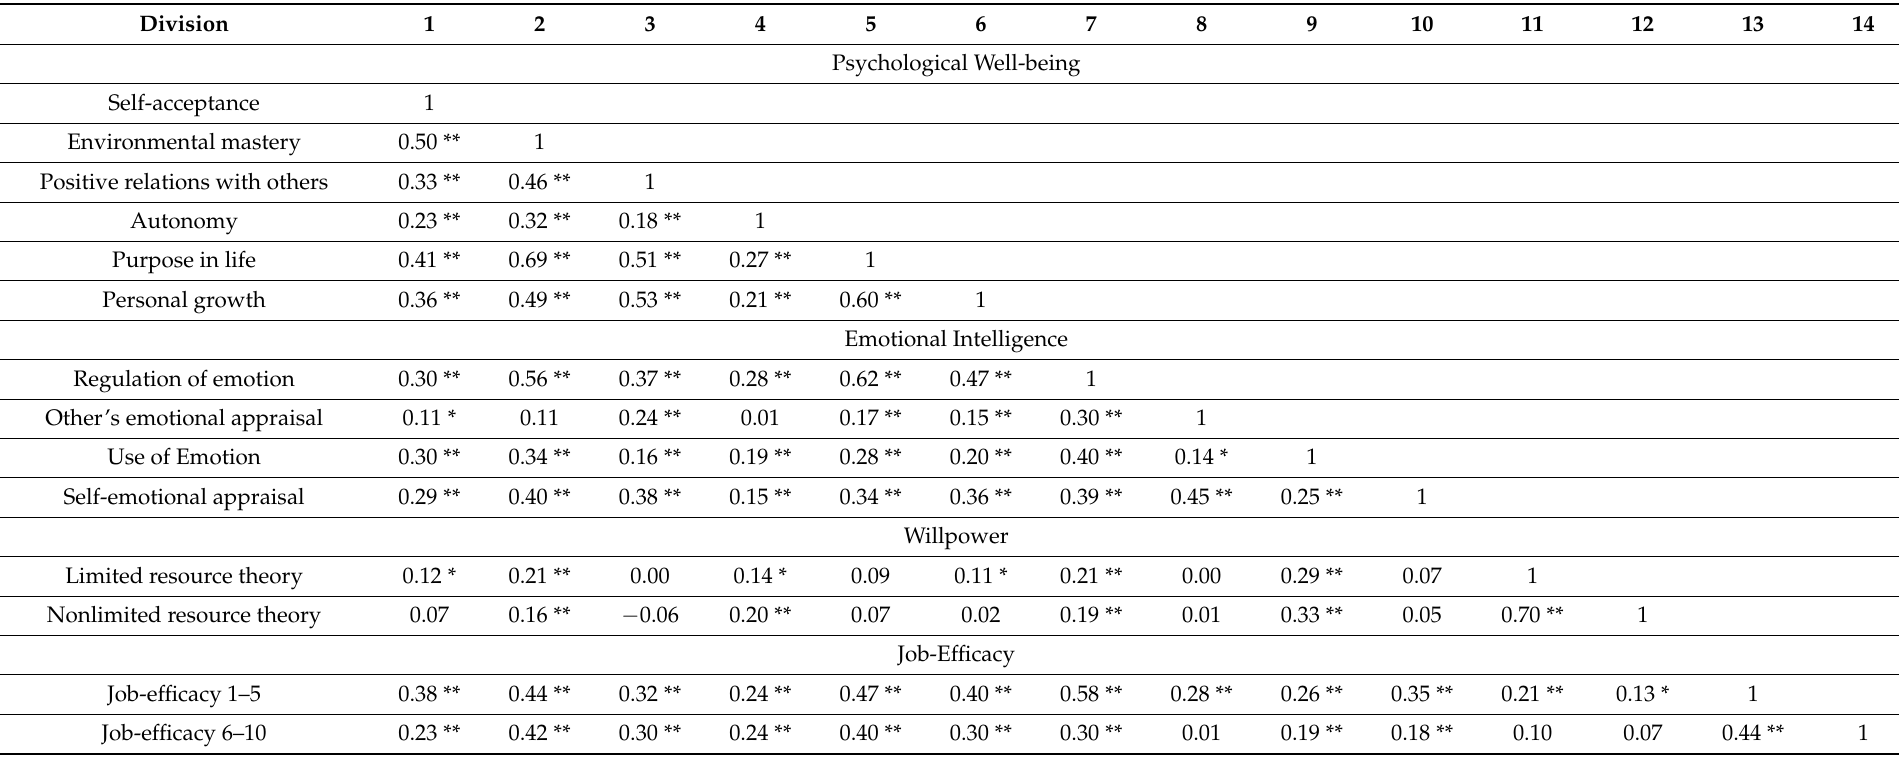
Table 3. Correlations between the observed